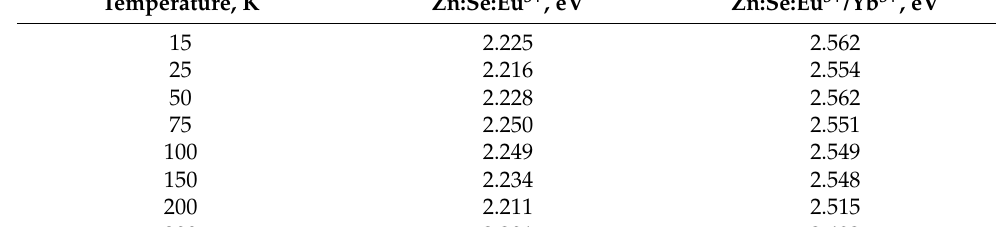
Table 1. Values of the direct band gaps of samples at different temperatures by UV–Vis spectropho- tometry and Kubelka–Munk theory.